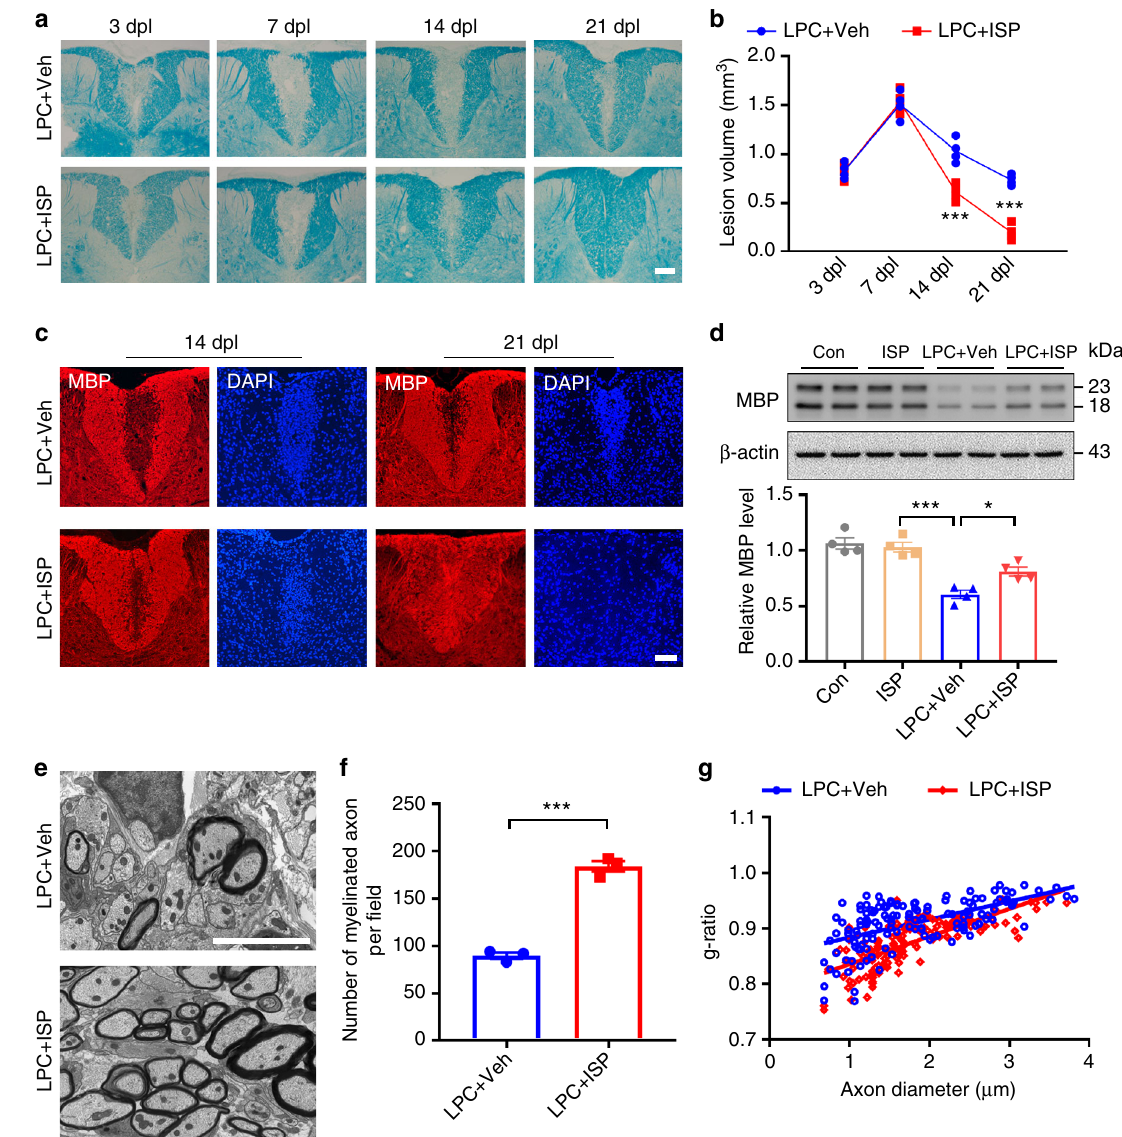
Fig. 3 ISP promotes remyelination in the spinal cord of lysolecithin (LPC)-demyelinated mice. a Representative LFB-stained sections of LPC lesions from the spinal cords of vehicle or ISP-treated mice. Dashed lines demarcate lesion areas. Scale bar = 100 μ m. b Quantitative analysis of the volume of lesioned spinal cord in vehicle or ISP-treated mice at 3, 7, 14, and 21 dpl ( n = 4 mice/group, ANOVA F(3,12) = 16.41; Sidak ’ s multiple comparison test, 14 dpl: P LPC + Veh versus LPC + ISP = 0.0003; 21 dpl: P LPC + Veh versus LPC + ISP < 0.0001). c Double immunostaining for MBP and DAPI in the spinal cord of vehicle- and ISP- treated mice at 14 and 21 dpl. Dashed lines demarcate lesion areas. Scale bars = 100 μ m. d Western blot analysis of MBP expression in spinal cord tissue of vehicle or ISP-treated mice at 14 dpl. Data are normalized to β -actin protein expression ( n = 4 mice/group, ANOVA F(3,12) = 24.21; Tukey ’ s multiple comparison test, P con versus LPC + Veh < 0.0001, P LPC + Veh versus LPC + ISP = 0.0276). e Representative electron microscopy images of LPC lesions from the spinal cord of vehicle or ISP-treated mice at 14 dpl. Scale bar = 5 μ m. f The number of myelinated axons in LPC-induced lesions from vehicle or ISP-treated mice at 14 dpl ( n = 3 mice/group, P = 0.0001, t = 14.26, df = 4; two-tailed unpaired Student ’ s t test). g The myelin g-ratio in the LPC lesions of vehicle or ISP- treated mice at 14 dpl (LPC + veh group, g-ratio = 0.9103 ± 0.003583; LPC + ISP group, g-ratio = 0.8741 ± 74103599; n = 139 remyelinated axons from 3 mice/group; P < 0.0001, t = 7.142, df = 276; two-tailed unpaired Student ’ s t test). The data are presented as mean ± s.e.m. * P < 0.05, ** P < 0.01, *** p <